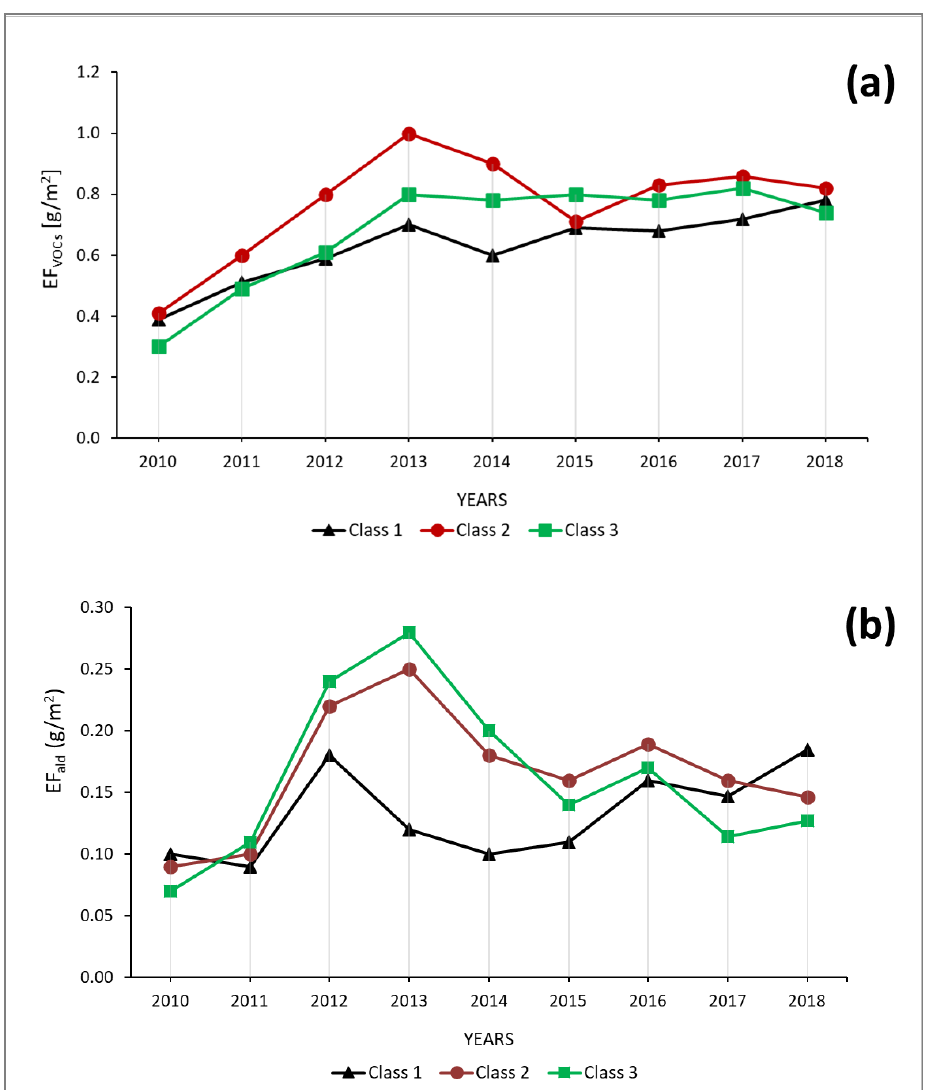
Figure 6. Trend for the emission factor of VOCs (EF VOCs ) ( a ) and aldehydes (EF ald ) ( b ) for the three production classes. production